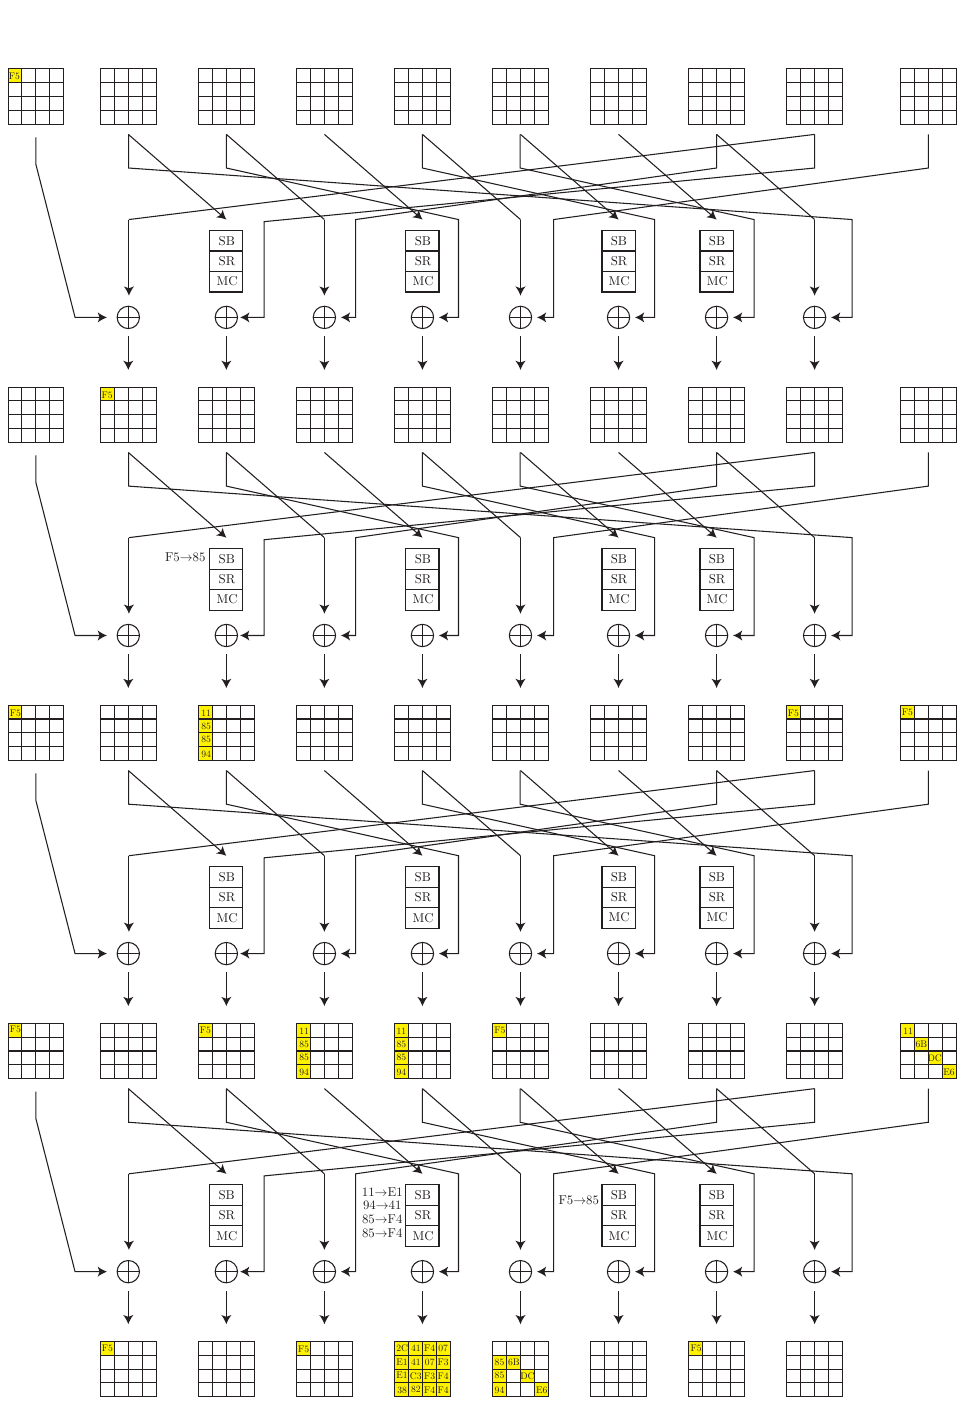
Figure 5: Top 4 rounds in the differential trail available for the forgery